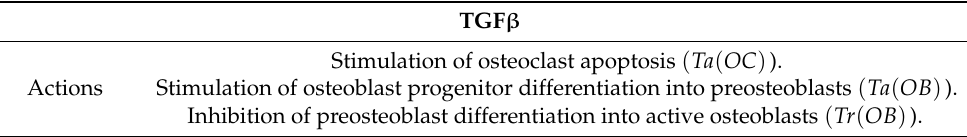
Table 1. TGF β actions and their mathematical formulation.